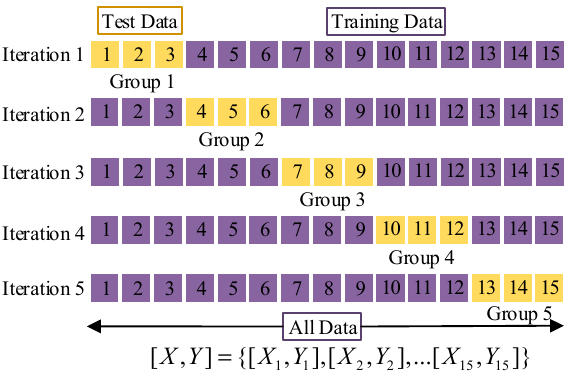
Figure 3. A schematic of K-fold cross-validation.